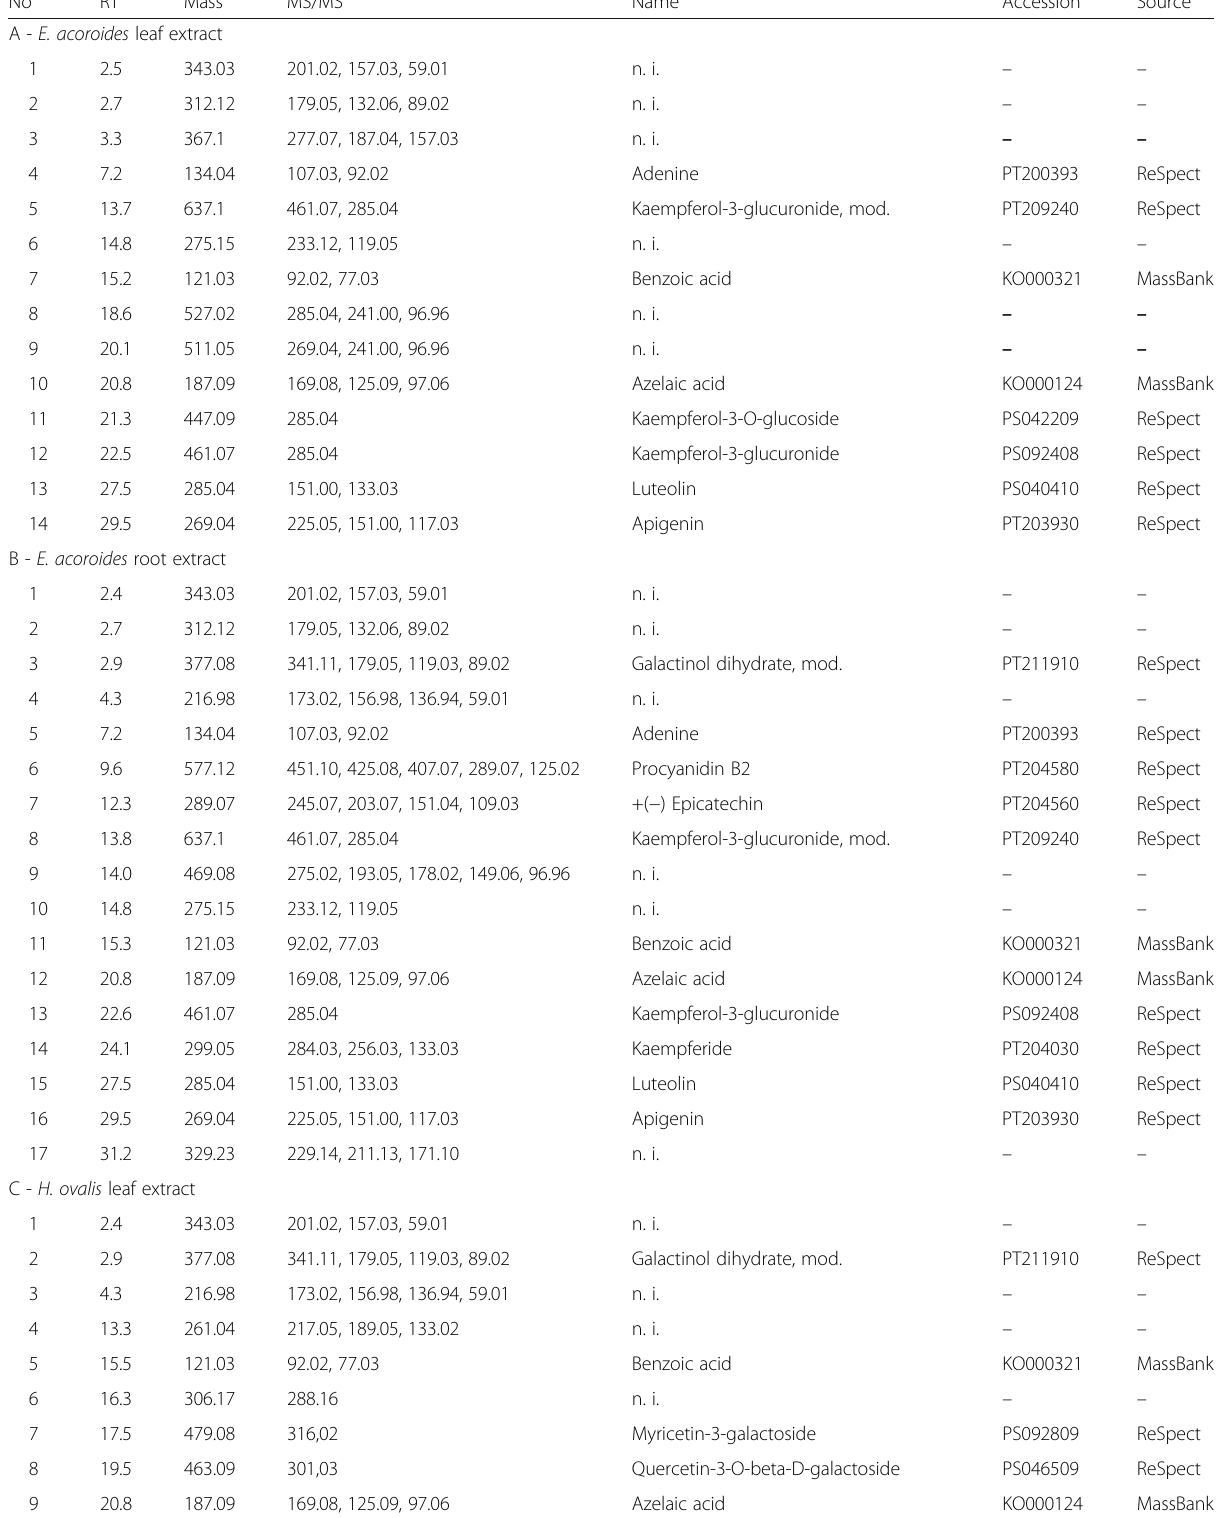
Table 2 Individual compounds identified by comparison of MS/MS spectra with database entries in Enhalus acoroides leaf